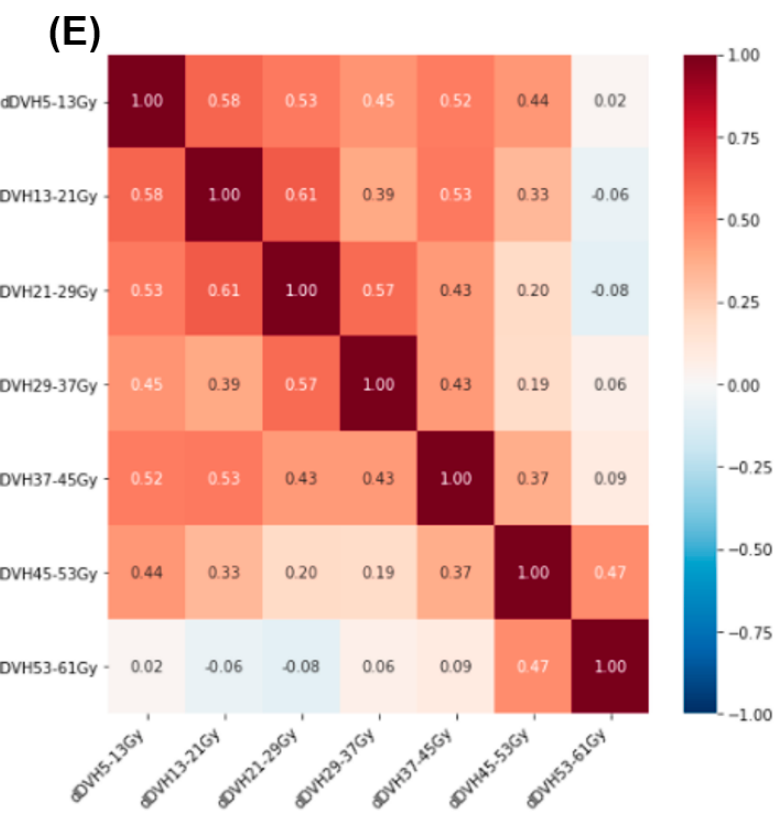
Figure 4. Feature correlation heat map illustrating the correlation between cDVH features ( A ) and dDVH features with dose bin = 2 Gy ( B ), 4 Gy ( C ), 6 Gy ( D ), and 8 Gy ( E ). Abbreviations: cDVH = cumulative dose − volume histogram; dDVH = differential dose − volume histogram.